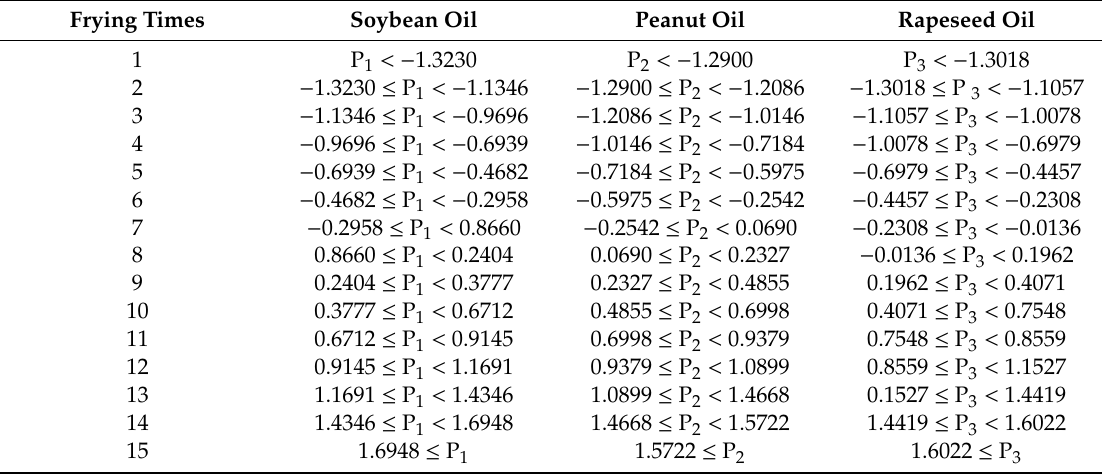
Table 2. The relationship between the size of the threshold and frying